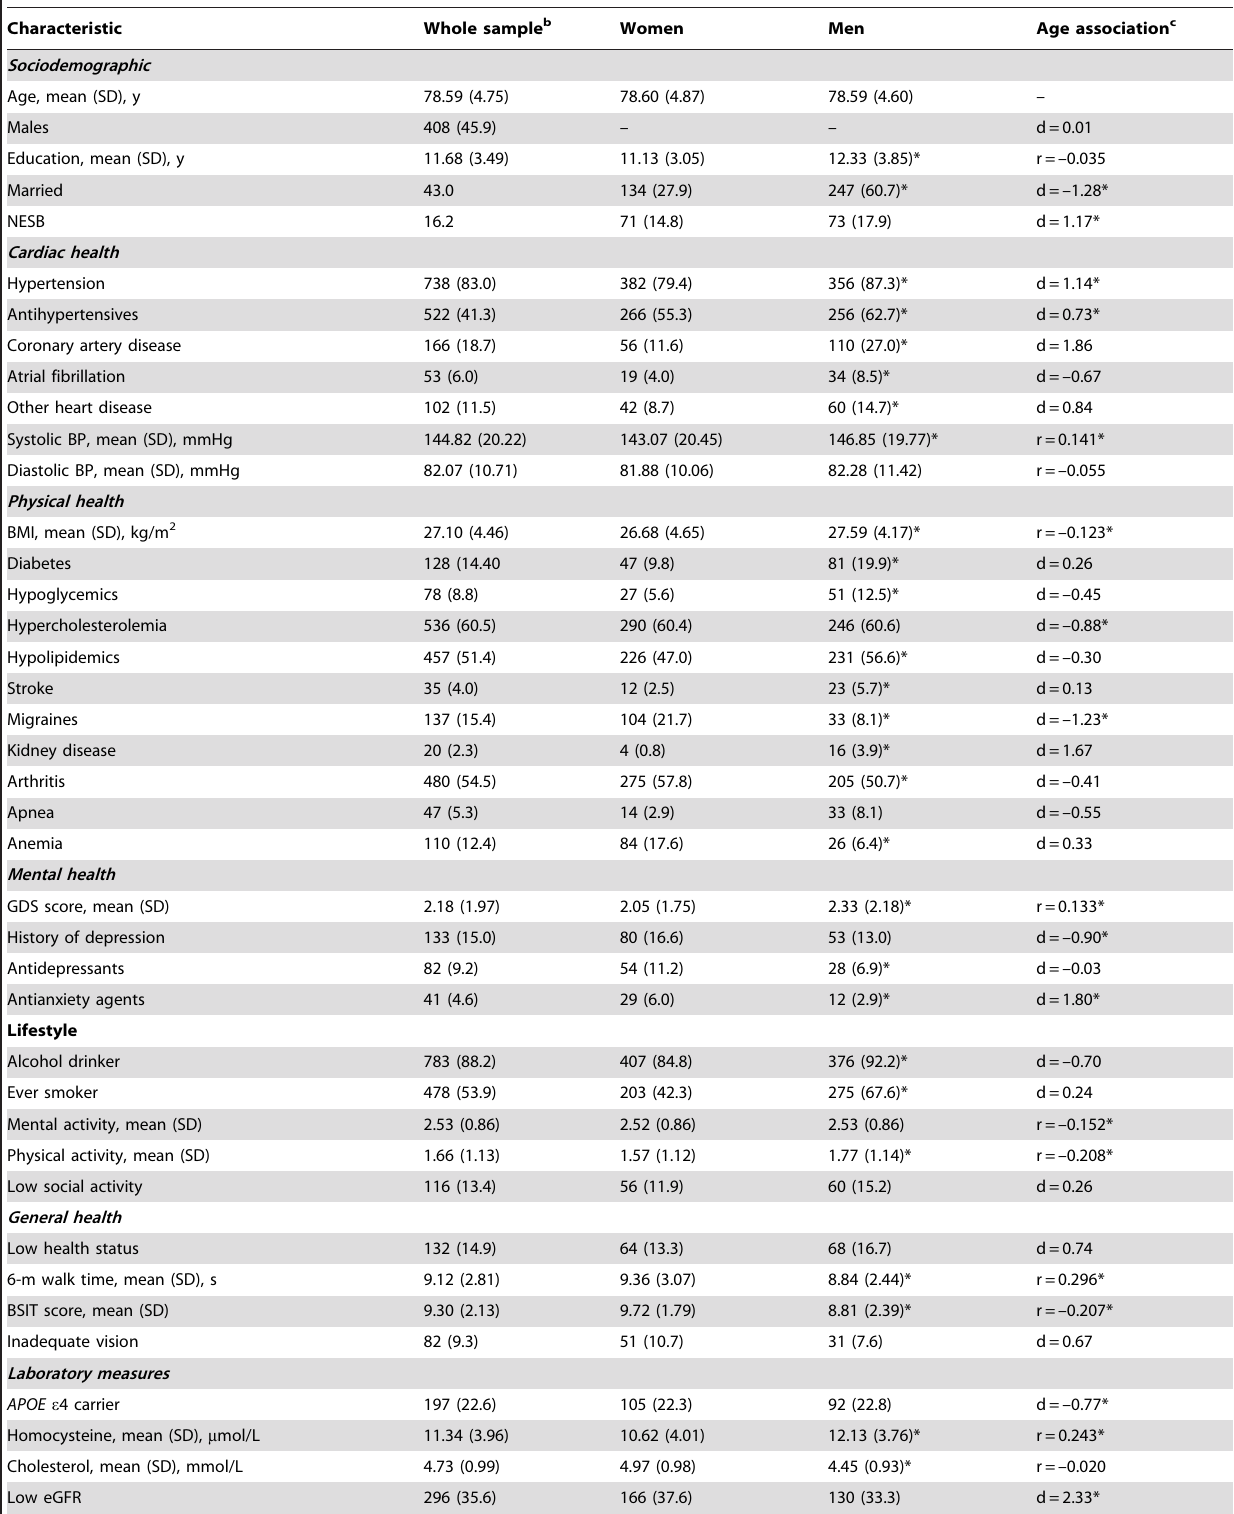
Table 1. Baseline characteristics of the study participants a